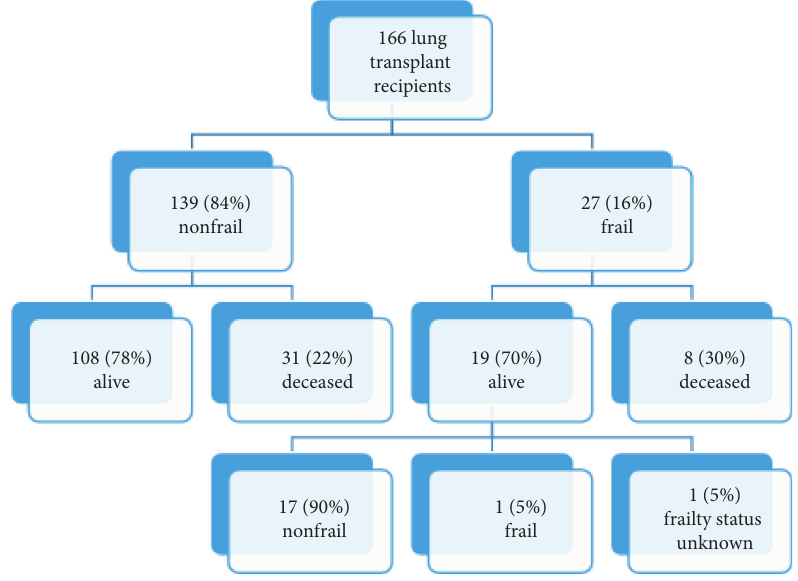
Figure 2: Outcome of nonfrail vs. frail patients post-LTX following reassessment of frail patients. Table 3: Comparison of clinical characteristics post-LTX of a study population stratified by physical frailty status.